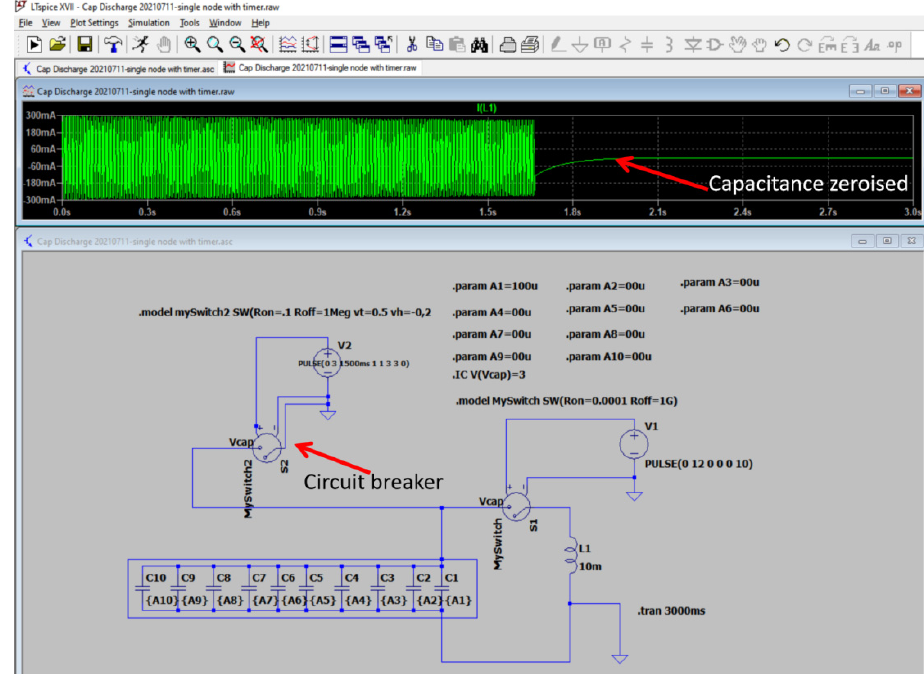
Figure 16. LTSPICE simulation of single node failure. Appl. Sci. 2021 , 11 , x FOR PEER REVIEW